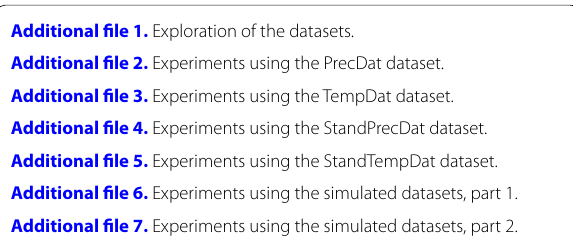
The minimum of the minimum values and the maximum of the maximum values are in